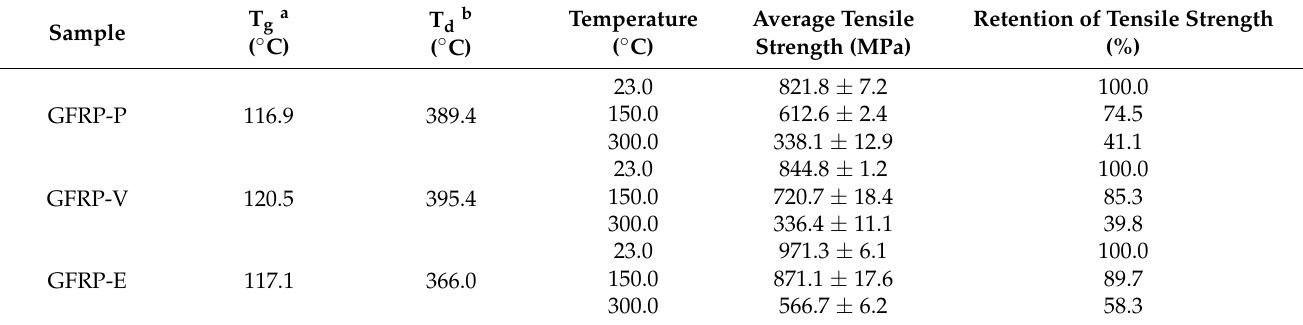
Figure 7. Force vs. displacement curves of samples: ( a ) GFRP P, ( b ) GFRP V, and ( c ) GFRP E. Table 4. Tensile test results of GFRP bars submitted to elevated